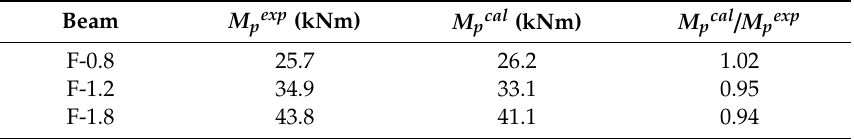
Table 6. Numerical analysis results of the Steel Fiber-Reinforced (SF)-UHPC